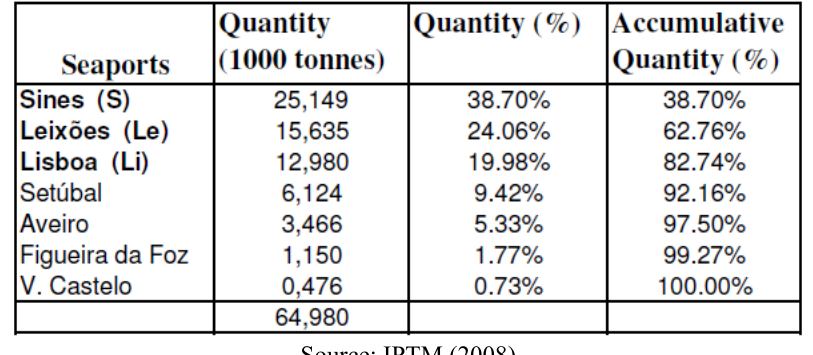
Figure 2: Iberian Peninsula seaports